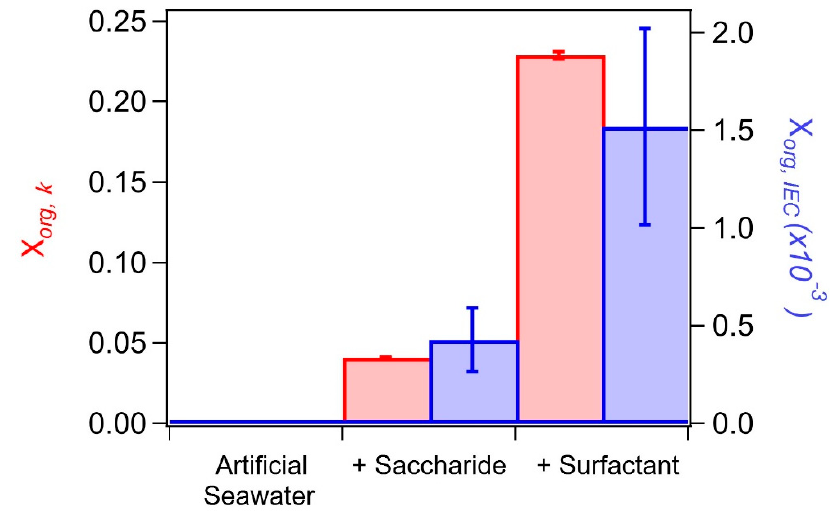
Figure 3. Aerosol organic volume fraction estimates for the salt water, glucuronic acid, palmitic acid sequential addition MART experiment (E1), calculated from hygroscopicity measurements (X org, κ ; red, error indicative of standard deviation from triplicate measurements) and IEC measurements (X org, IEC ; blue, absolute error from IEC measurement).